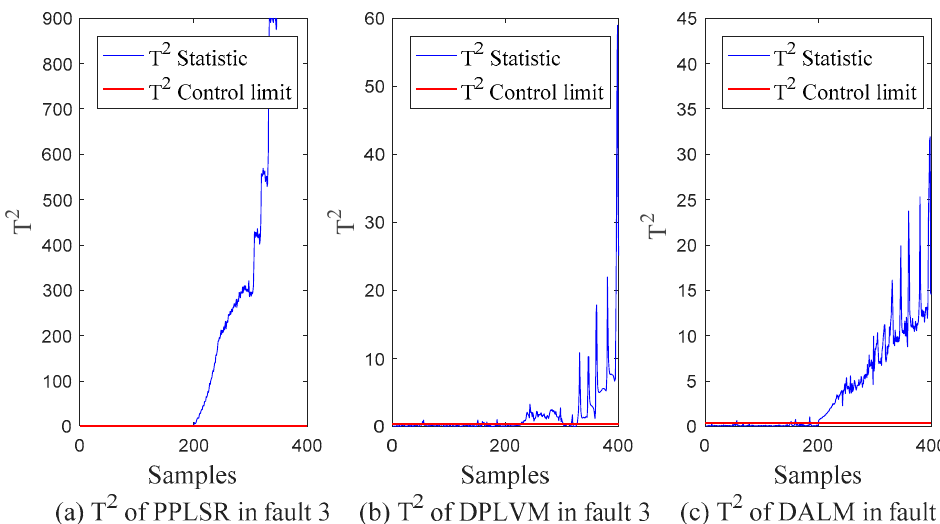
Figure 8. Monitoring results of fault 3. ( a ) T 2 of PPLSR in fault 3; ( b ) T 2 of DPLVM in fault 3; ( c ) T 2 of